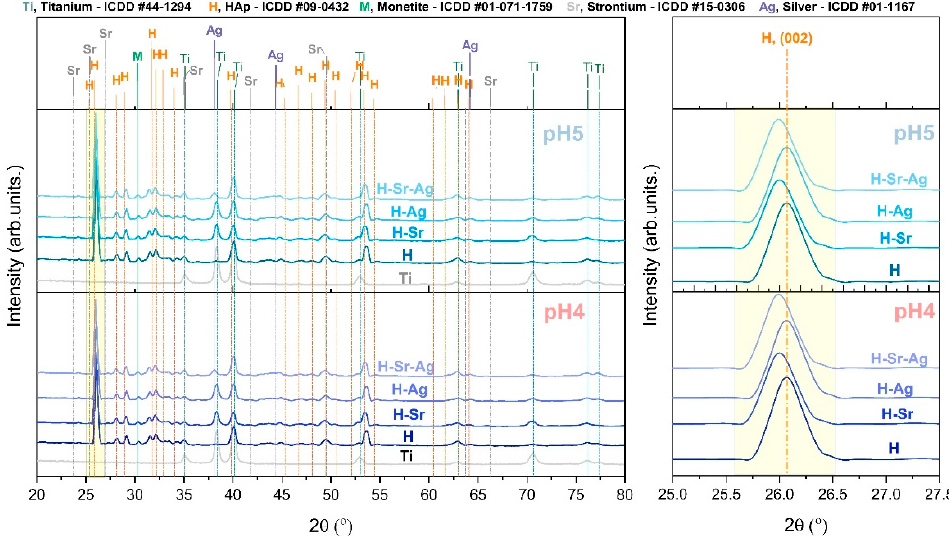
Figure 4. XRD diffractograms of the electrochemically deposited coatings on Ti substrate. A small diffraction peak located at 30.31° was assigned to monetite (CaHPO 4 ) according to ICDD card No. 01-071-1759, indicating the presence of a secondary phase. Monetite is an important calcium phosphate precursor that promotes cell proliferation, being recognized for its osseoinductive and osteoconductive character [69].